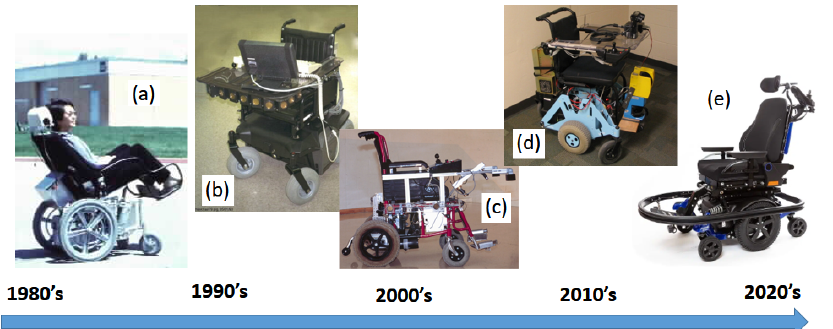
Figure 2. Intelligent wheelchairs timeline; some examples. ( a ) Head control [13]; ( b ) Navchair, with an ultrasonic ring for navigation [15]; ( c ) SIAMO, with voice commands and infrared safety sensors [1]; ( d ) Vulcan 1.0, from the University of Texas [17]; ( e ) Smart Rehab commercial wheelchair